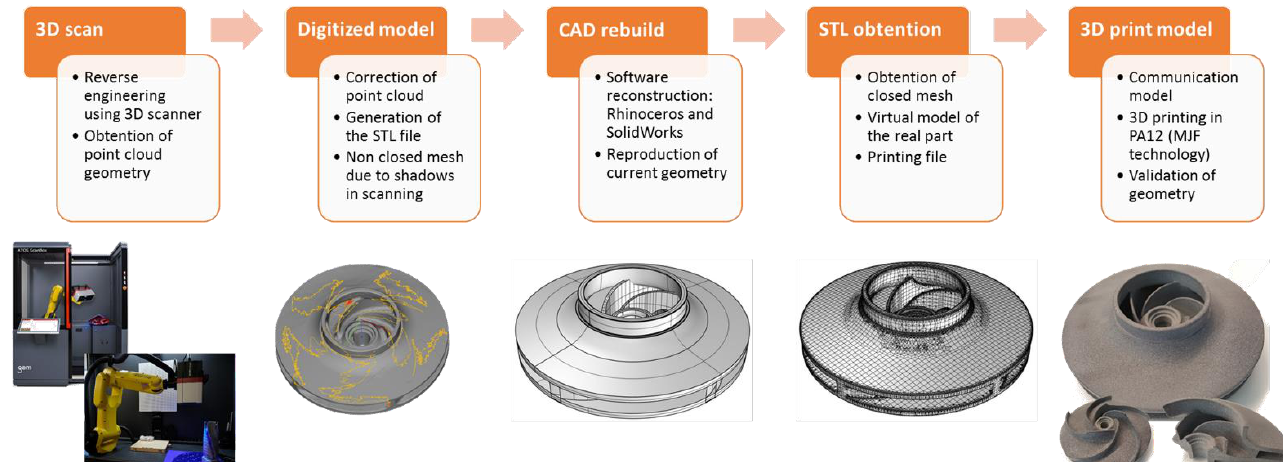
Figure 1. Digitalization and CAD design for BJ impeller fabrication.